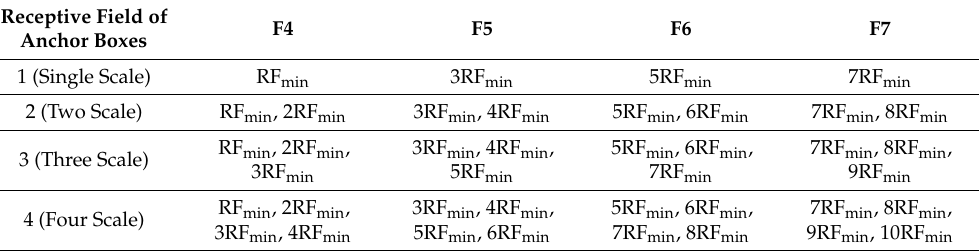
Table 2. Options for Anchor boxes.